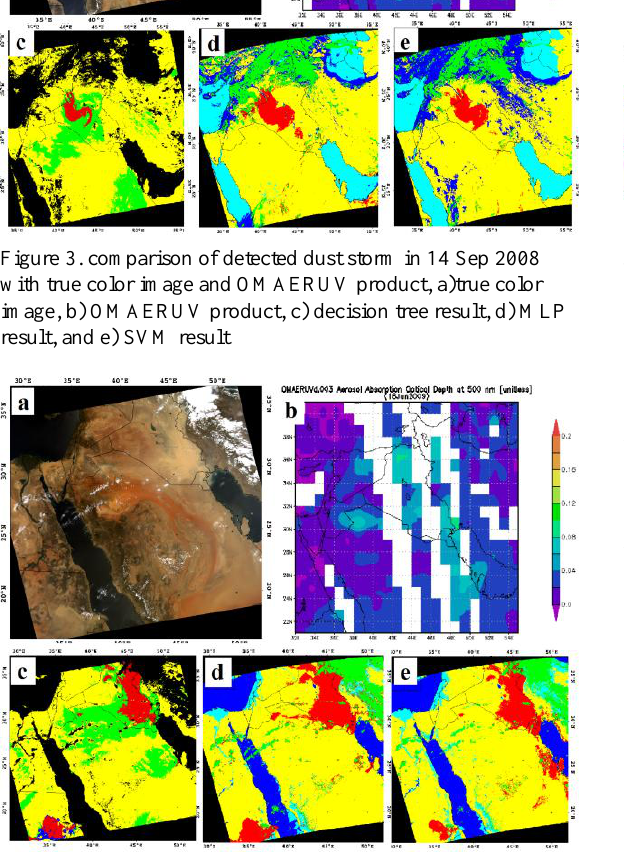
Figure 4. Comparison of detected dust storm in 18 Jun 2009 with true color image and OMAERUV product, a) true color image, b) OMAERUV product, c) decision tree result, d) MLP result, and e) SVM result